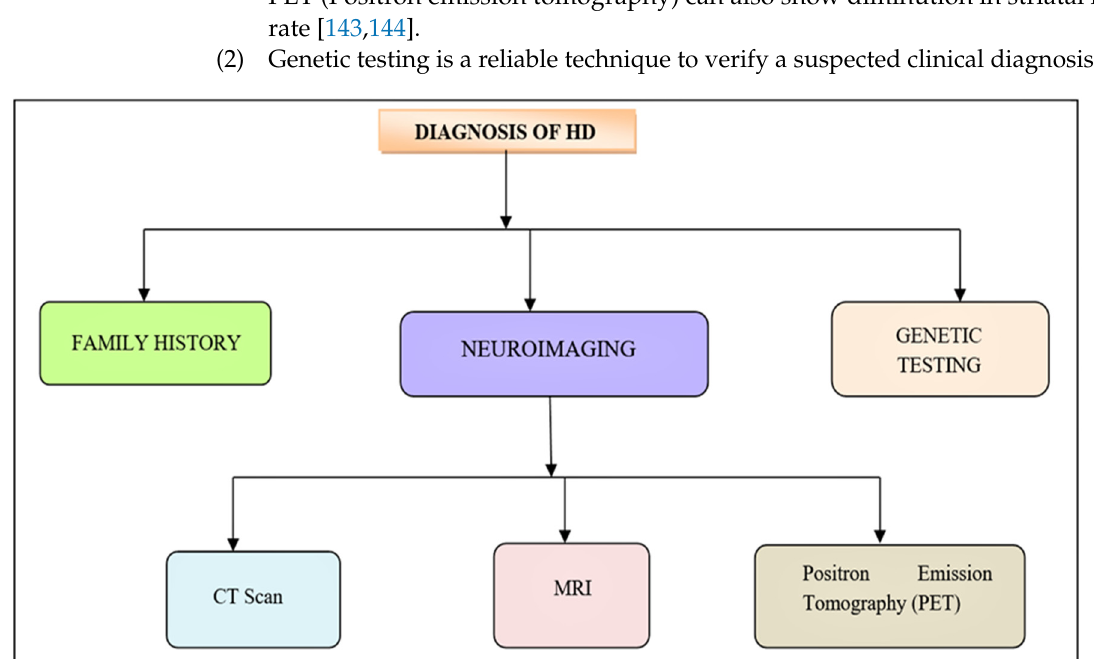
Figure 6. Diagnosis of HD. The initial clinical manifestation of HD is similar to the neurological diseases. Neurological test, definitive genetic examination along with foremost family history is recommended for the diagnosis of HD.